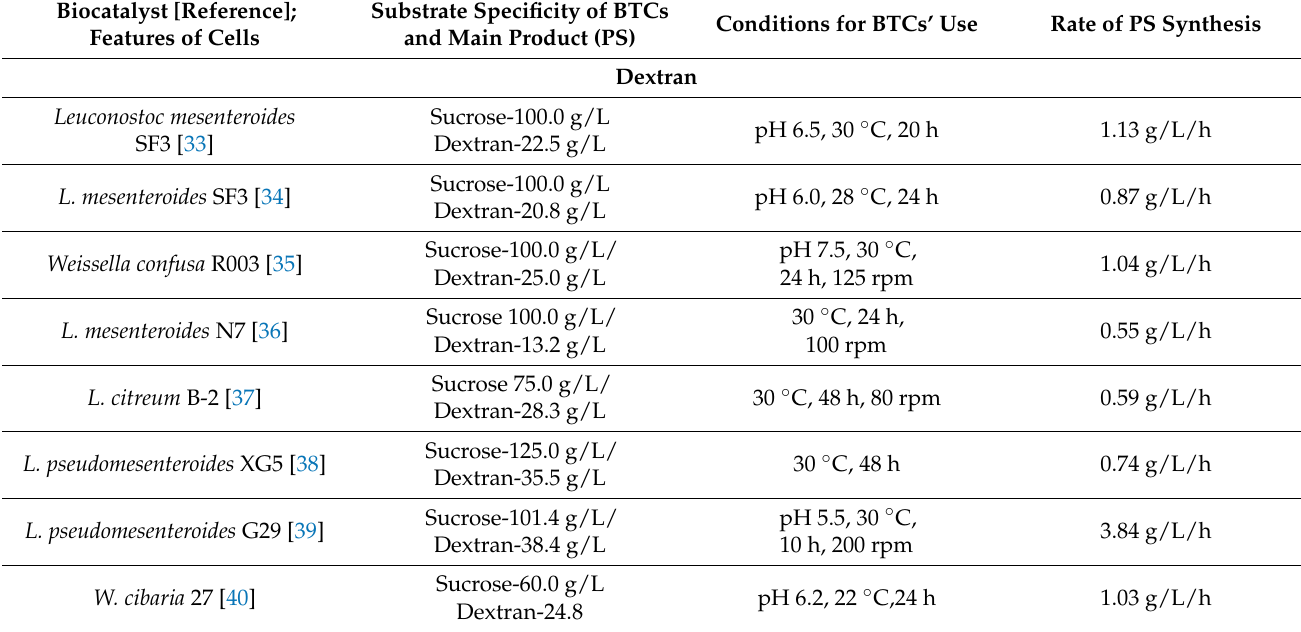
Table 1. BTCs based on microbial monocultures for PSs